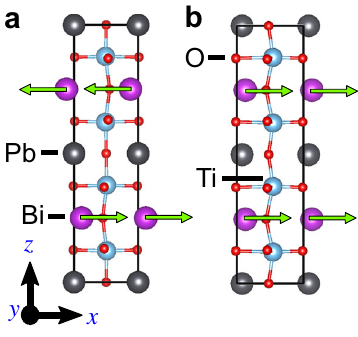
Fig. 7 The comparison between anti-polar and polar phases of BPTO. a The unit cell structure of anti-polar phase Pmma of BPTO. b The two unit cells structure of polar phase Pmm 2 of BPTO. The green arrows indicate the polar displacements of the Bi 3 and